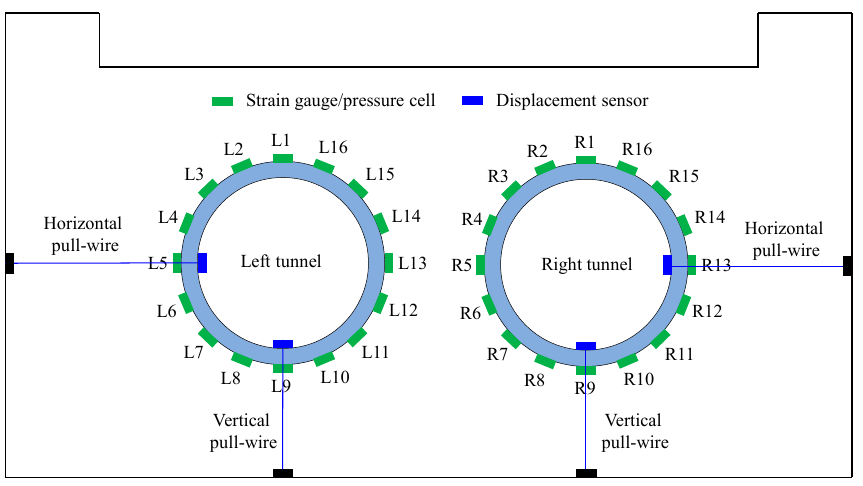
Figure 6. Arrangement of measuring sensors.